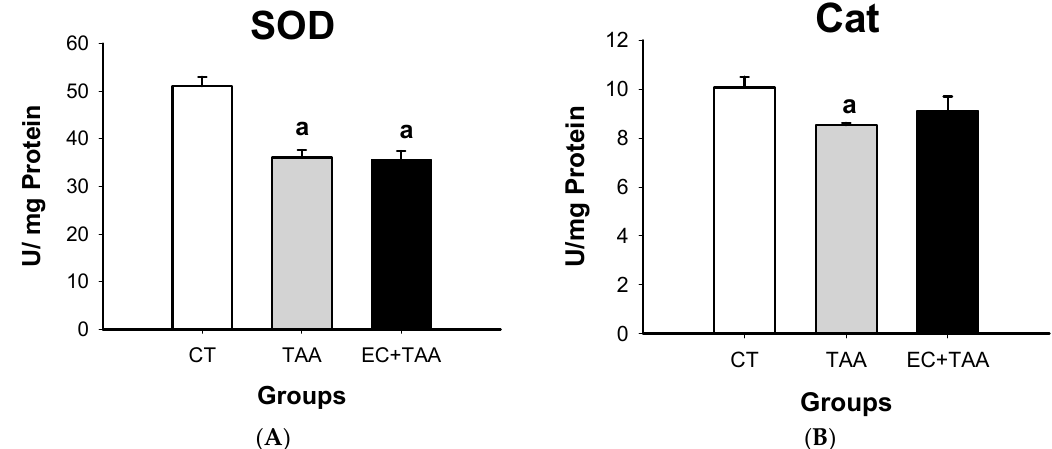
Figure 5. Effect of EC pretreatment on levels of ( A ) SOD and ( B ) Cat enzyme activities in rats’ liver intoxicated by a sublethal dose of thioacetamide (TAA). The results are expressed in U/mg protein. Bars indicate the mean value with the SE of two determinations (n = 8). The differences compared with the vehicle are expressed as “ a ”; while the differences due to TAA are expressed as “ b ”, p ≤ 0.05.